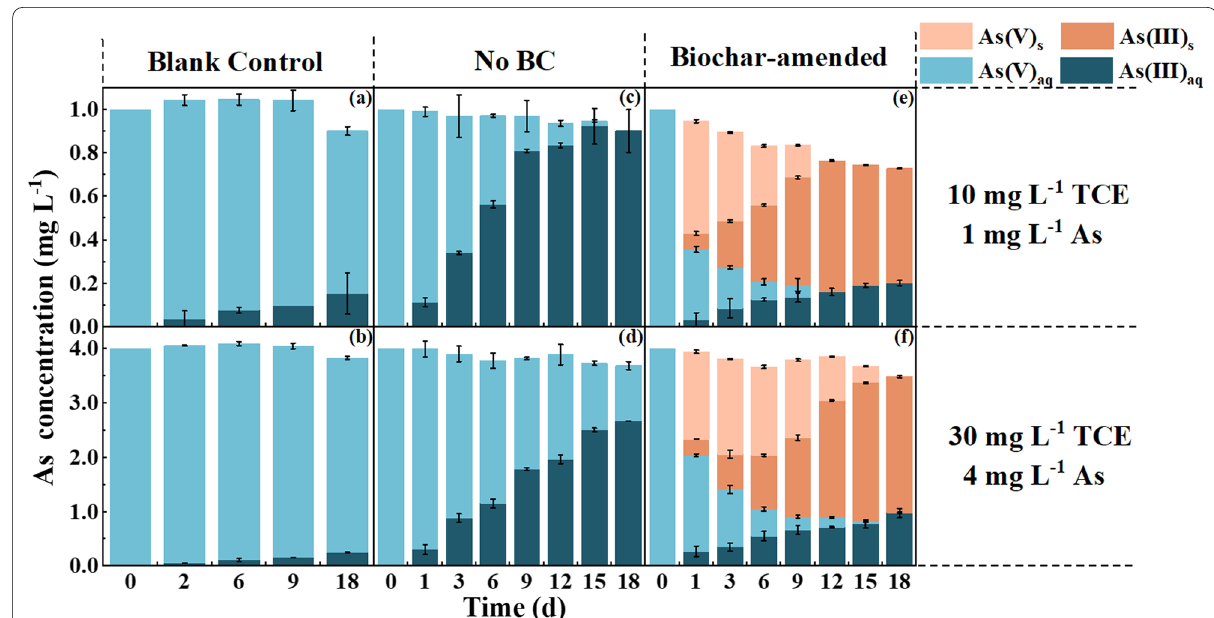
Fig. 4 The distribution of As(V) and As(III) in aqueous [As(V) aq and As(III) aq ] and biochar solid phase [As(V) s and As(III) s ] of the co-removal systems along the process. ( a ), ( c ) and ( e ) refer to the low concentration system, while ( b ), ( d ) and ( f ) indicate the high concentration